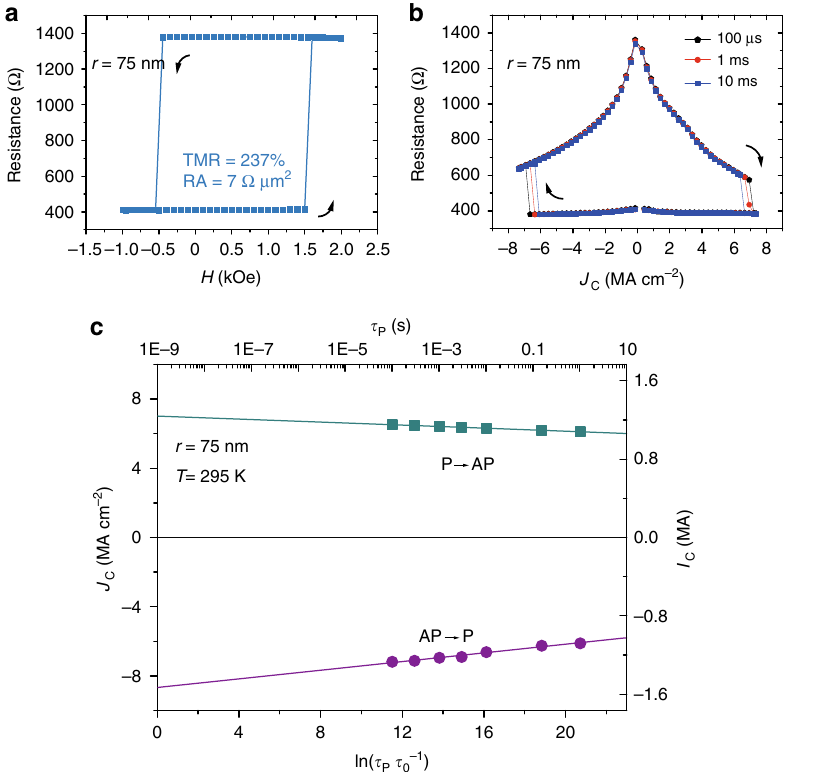
Fig. 3 Magnetoresistance and STT measurements for p-MTJ ( r = 75 nm) after optimization at room temperature. a Magnetoresistance as a function of out- of-plane magnetic fi eld. b STT switching measured with pulse current at various τ P . c J C as a function of ln( τ P / τ 0 ). Arrows show the perpendicular magnetization transitions from AP to P states or the opposite